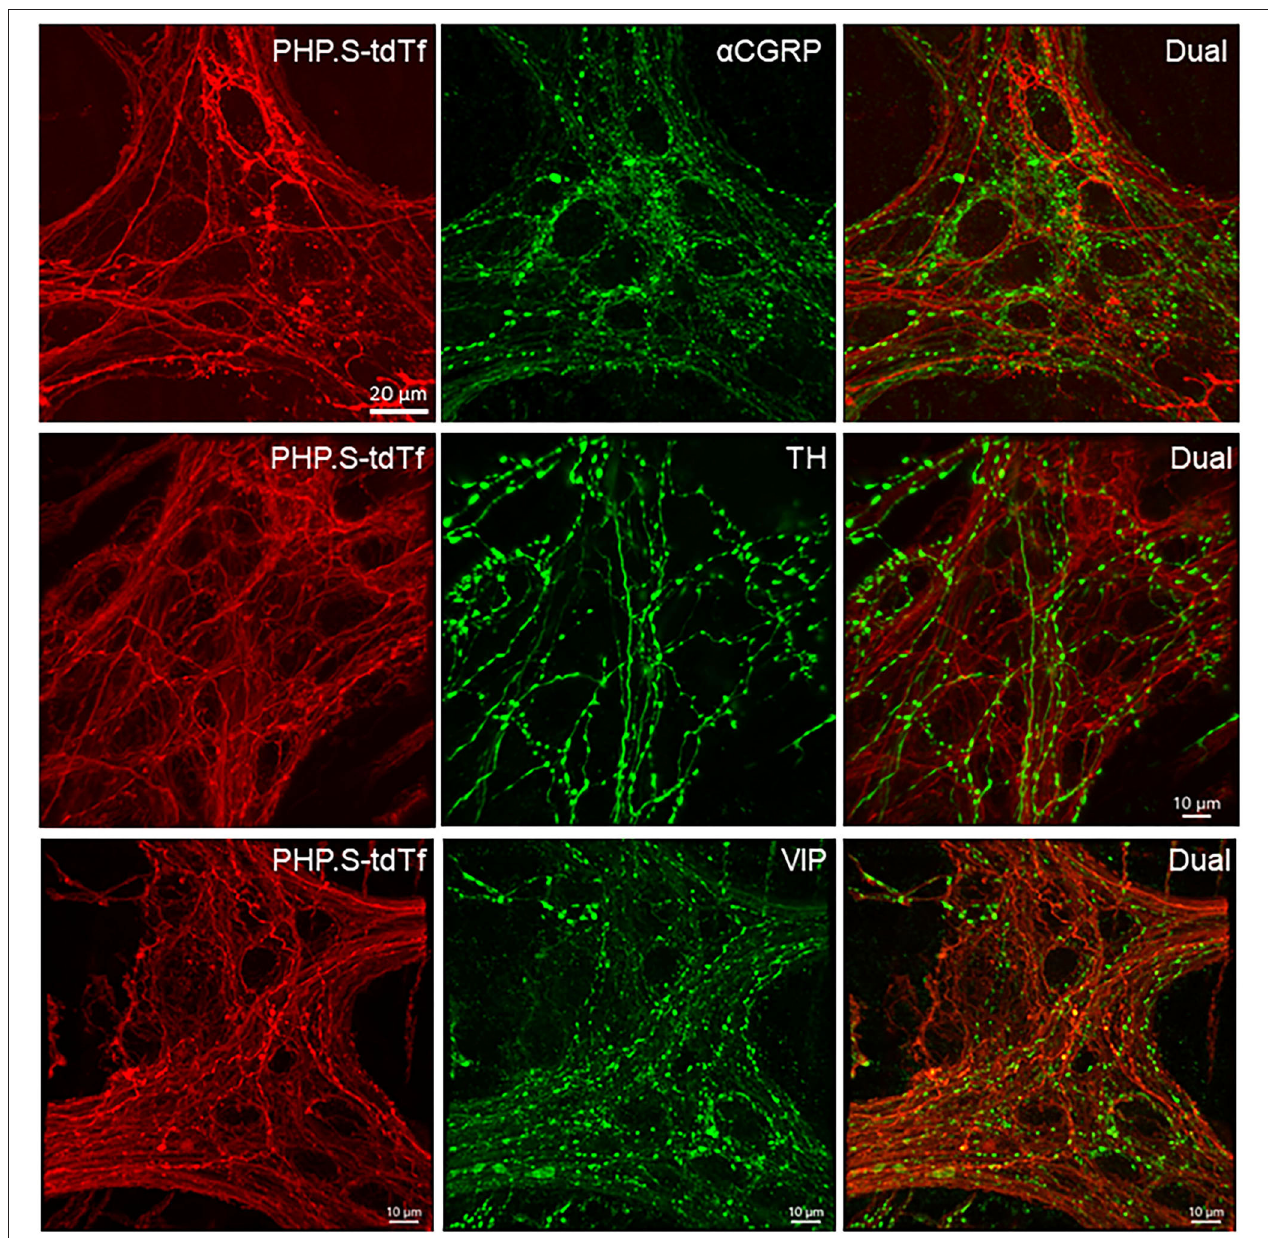
FIGURE 13 | Photomicrographs at high magnification of PHP.S-tdTf transduction in the myenteric plexus of the mouse proximal colon combined with immunofluorescence of calcitonin gene related peptide-alpha ( α -CGRP), tyrosine hydroxylase (TH), and vasoactive intestinal peptide (VIP). Few co-localizations of AAV-tdTf with α CGRP, TH-ir, or VIP-ir were found. Scale bar 20 µ m, same for all